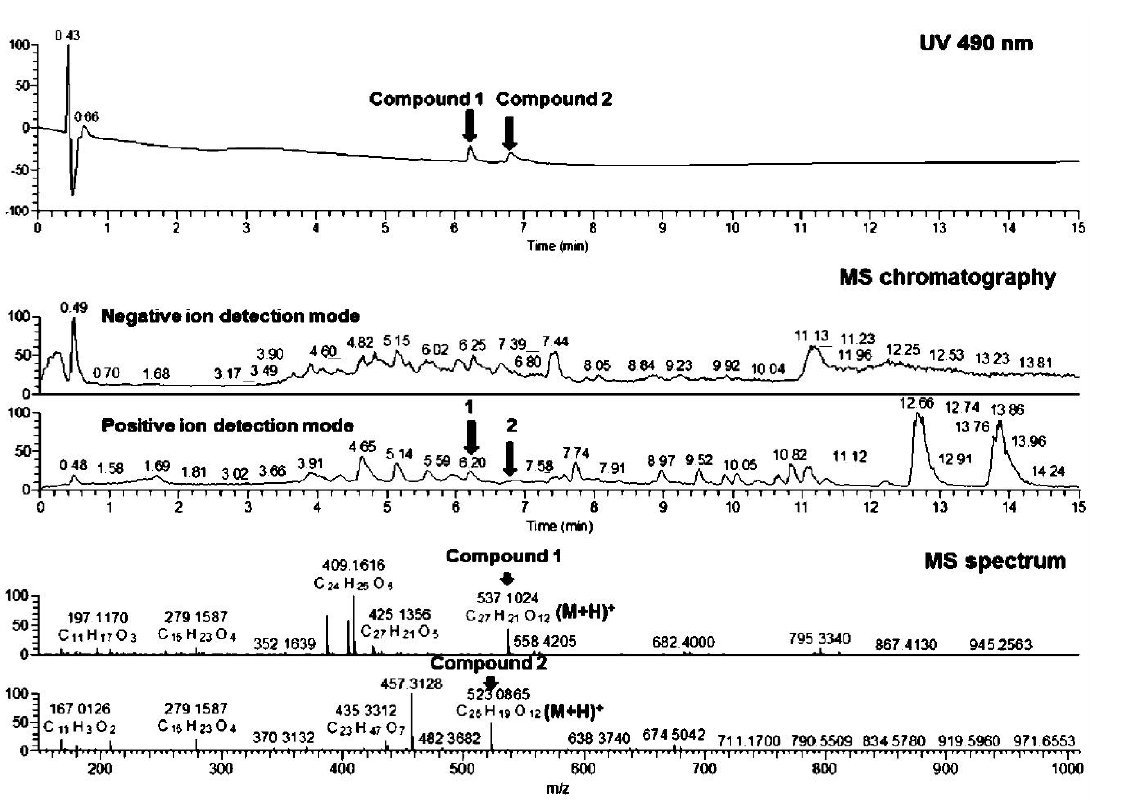
Figure 3. LC-MS analysis of the EtOAc extract from the culture broth of Streptomyces sp. ADR1.